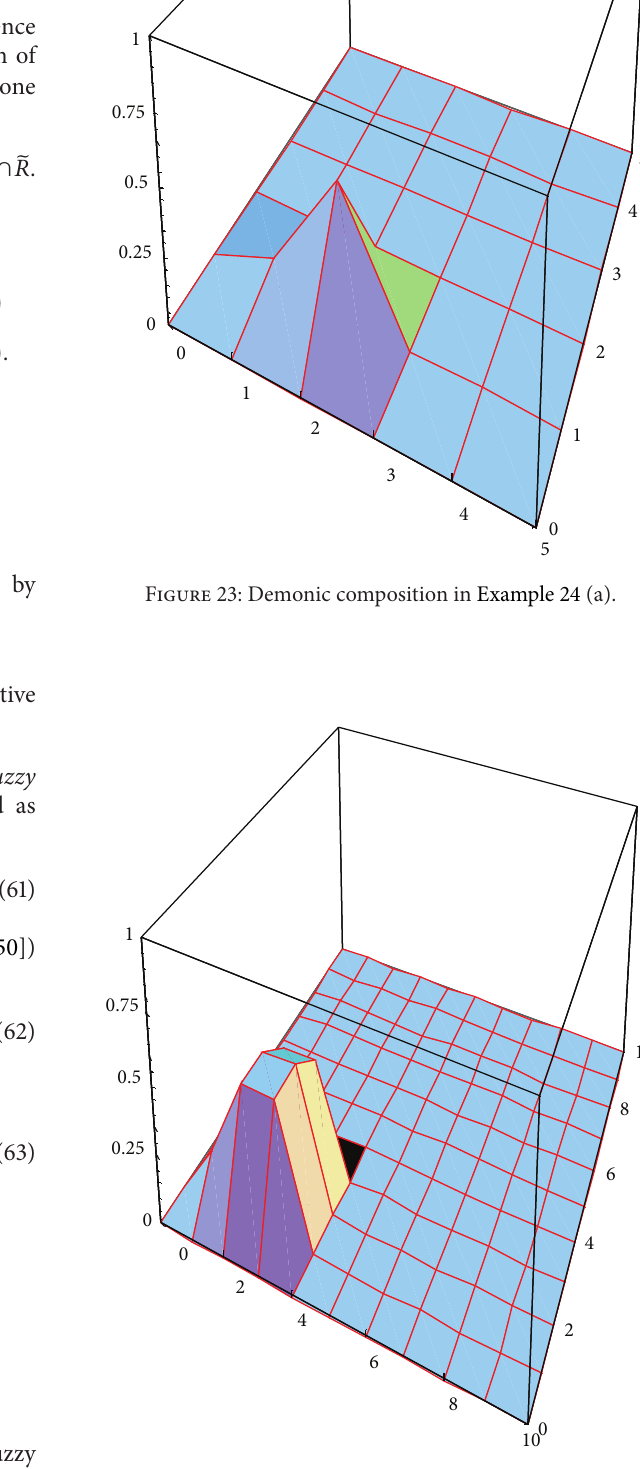
Figure 24: Demonic composition in Example 24